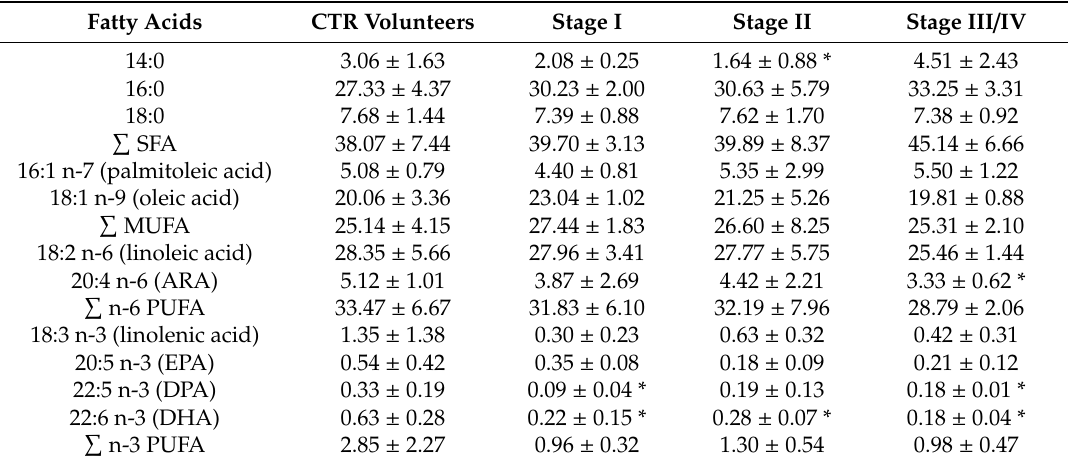
Table 3. Fatty acid (FA) composition (relative %) of plasma total lipids in control (CTR) volunteers and colon cancer (CC) patients at di ff erent cancer